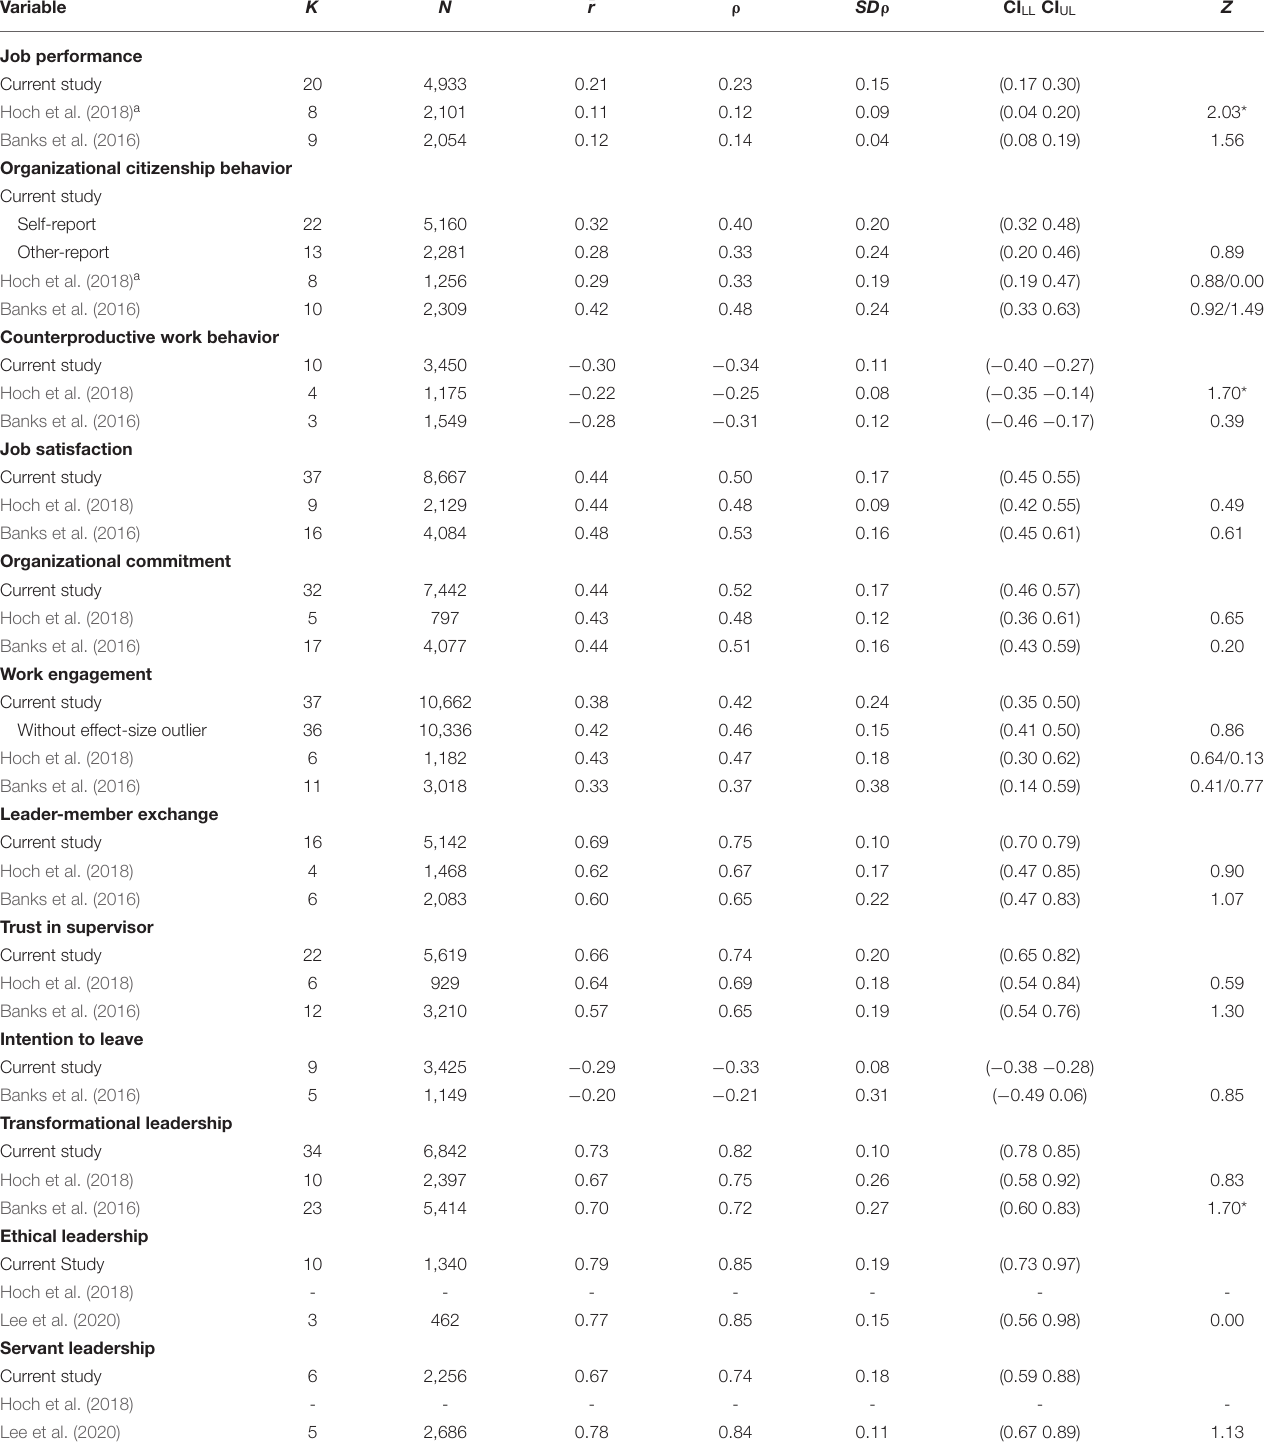
TABLE 4 | Comparison of current and prior meta-analytic results for authentic leadership.